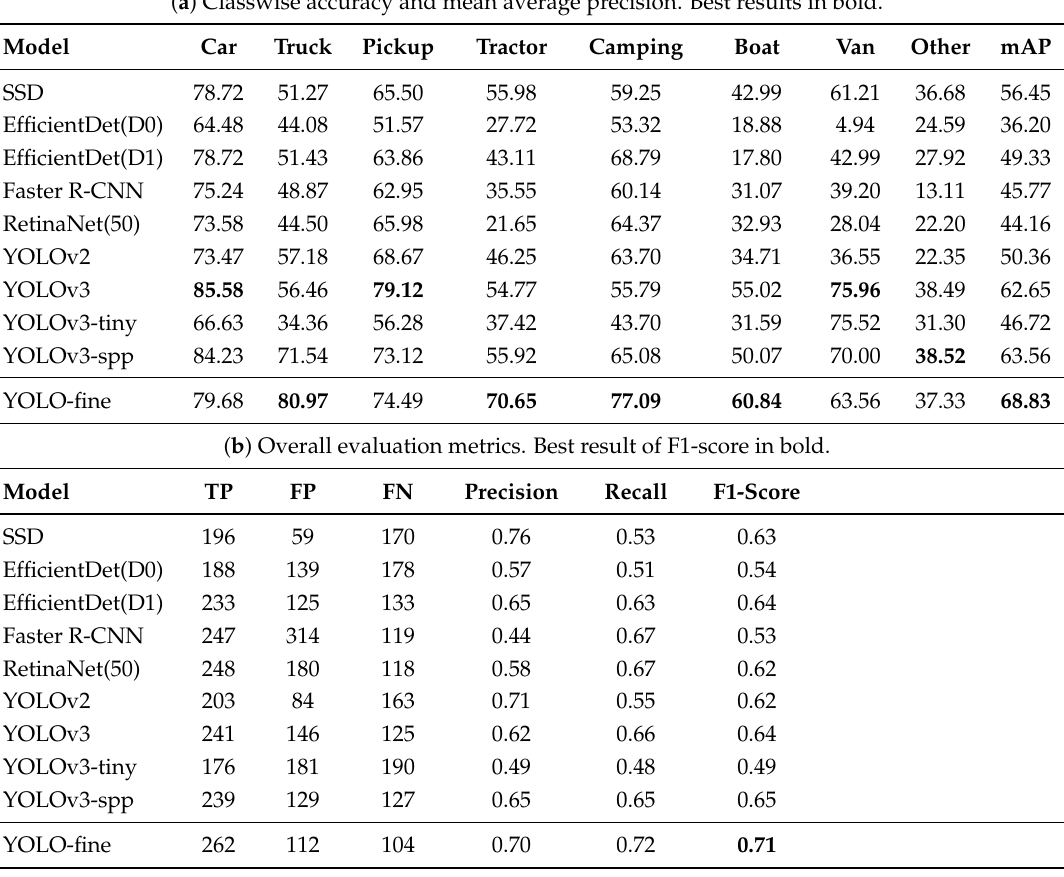
Table 4. Detection results on VEDAI512 (infrared